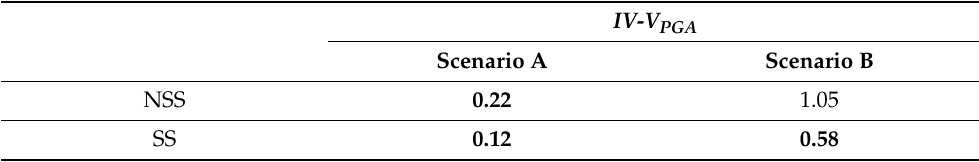
Table 8. Nonlinear static analysis (NLSA) configuration with MMPO approach—pile 14S X-dir. check (vulnerability index). Unsatisfied verifications are highlighted in bold, worst condition is